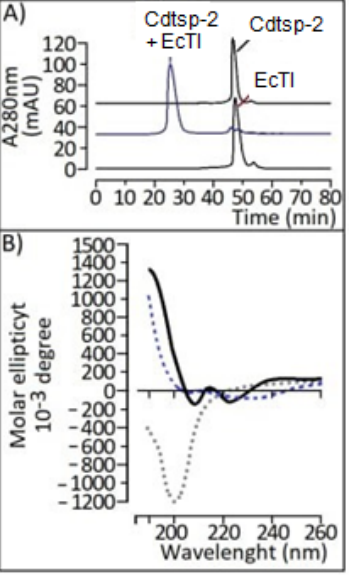
Figure 8. ( A ): Analysis of interaction through HPLC molecular exclusion. ( B ): Analysis on bench circular dichroism, Jasco, with monitoring at 190 to 260 nm in 0.1%TFA and 66% ACN buffer and the protein with concentration 0.02 mg/mL. Profile analysis (recording the differentiated absorption of polarized light) was given by Spectra manager program: “Randon coil” about 61% of the structure, 17.84% of the structure is organized in alpha-helices; 21.16% in